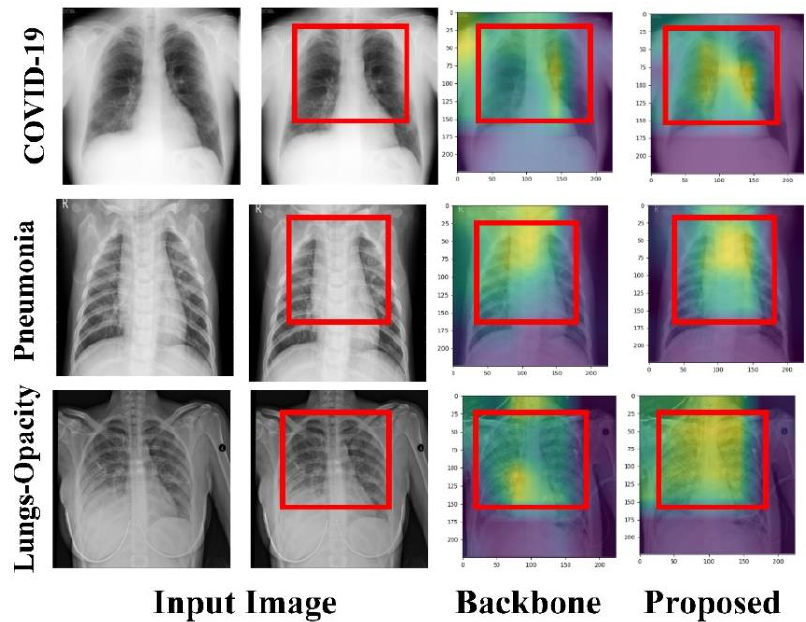
Figure 9. A Grad-CAM-based visualization of the proposed model on the different input data samples. The proposed model focuses on visual features of the image that are semantic information important for classification .